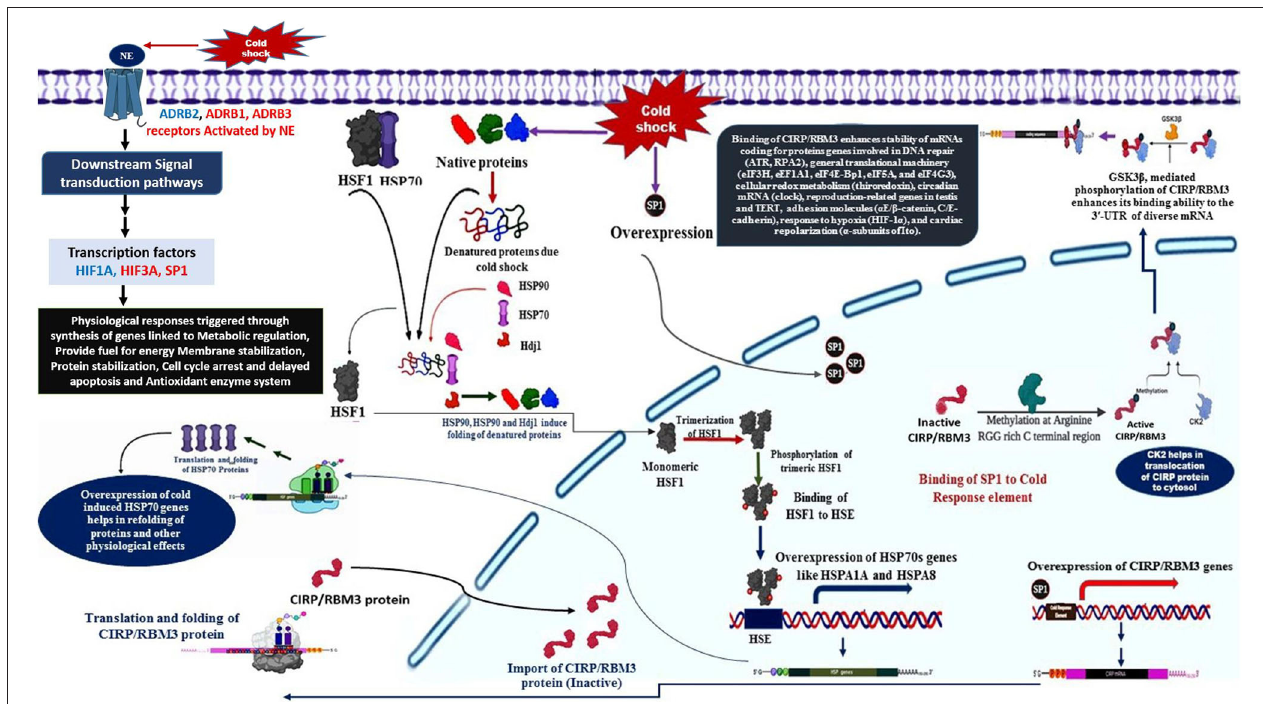
FIGURE 1 | Biological model with assigned role of various cold response